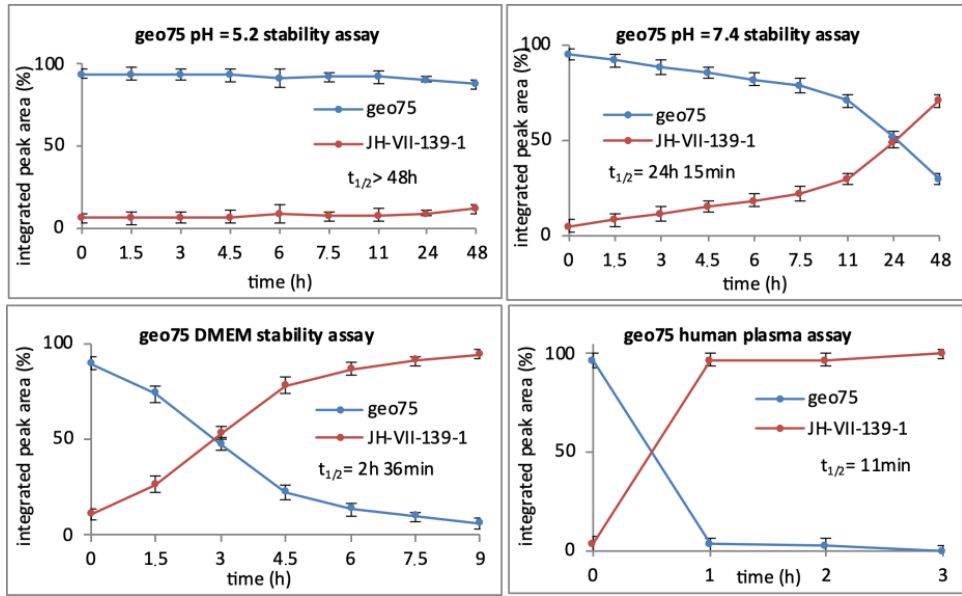
Figure 3. Chemostability of conjugate geo75 .